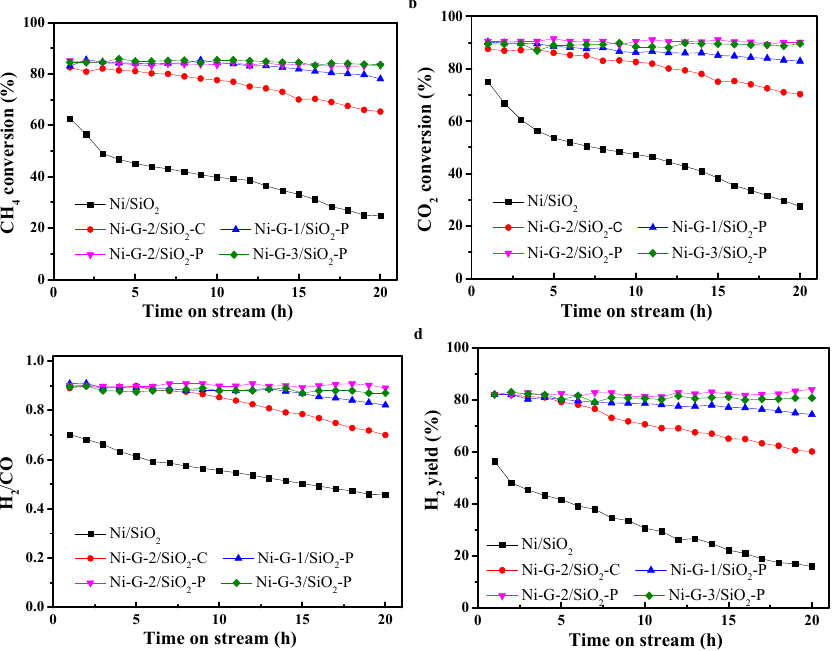
Figure 5. CH 4 conversion ( a ), CO 2 conversion ( b ), H 2 /CO ( c ) and H 2 yield ( d ) over Ni/SiO 2 , Figure 5. CDR performance over Ni/SiO 2 ( a ), Ni-G-2/SiO 2 -C ( b ), Ni-G-1/SiO 2 -P ( c ), Ni-G-2/SiO 2 -P ( d ), and Ni-G-3/SiO 2 -P ( e ) catalysts at the conditions of P = 0.1 MPa, T = 750 o C, CH 4 /CO 2 = 1, and Ni-G-2/SiO 2 -C, Ni-G-1/SiO 2 -P, Ni-G-2/SiO 2 -P and Ni-G-3/SiO 2 -P catalysts at the conditions of GHSV = 120,000 mL·g − 1 ·h − 1 . P = 0.1 MPa, T = 750 ◦ C, CH 4 /CO 2 = 1, and GHSV = 120,000 mL · g − 1 · h − 1